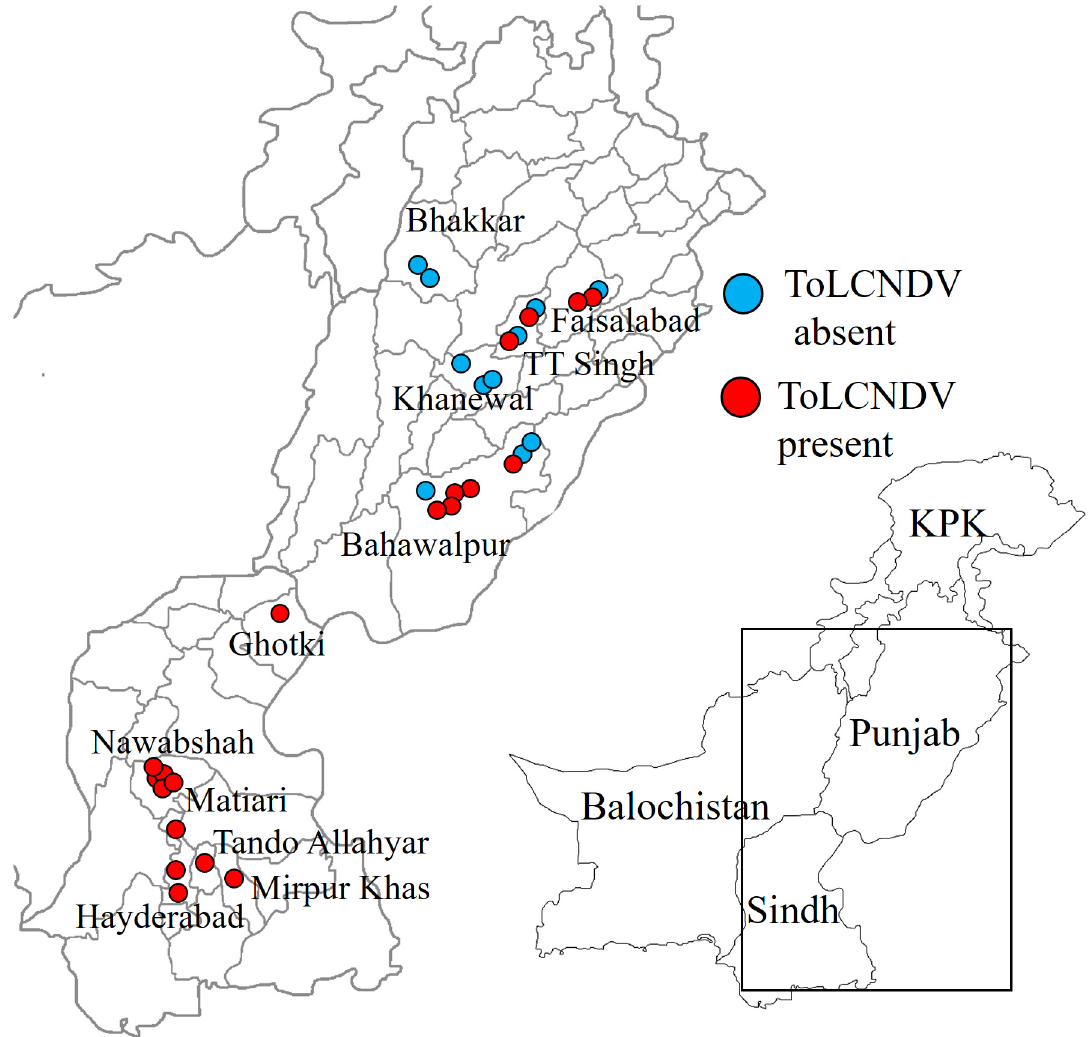
Fig 3. Distribution of samples shown to harbour coinfection of CLCuKoV-Bur and ToLCNDV across Pakistan. The map shows the origin of collected cotton plant samples with CLCuD symptoms. Plants shown by diagnostic PCR to contain both CLCuKoV-Bur and ToLCNDV are shown as red dots, whereas plants shown only to contain CLCuKoV-Bur are shown as blue dots. The map depicting putative boundaries is drawn by the author and provided here for illustrative purpose